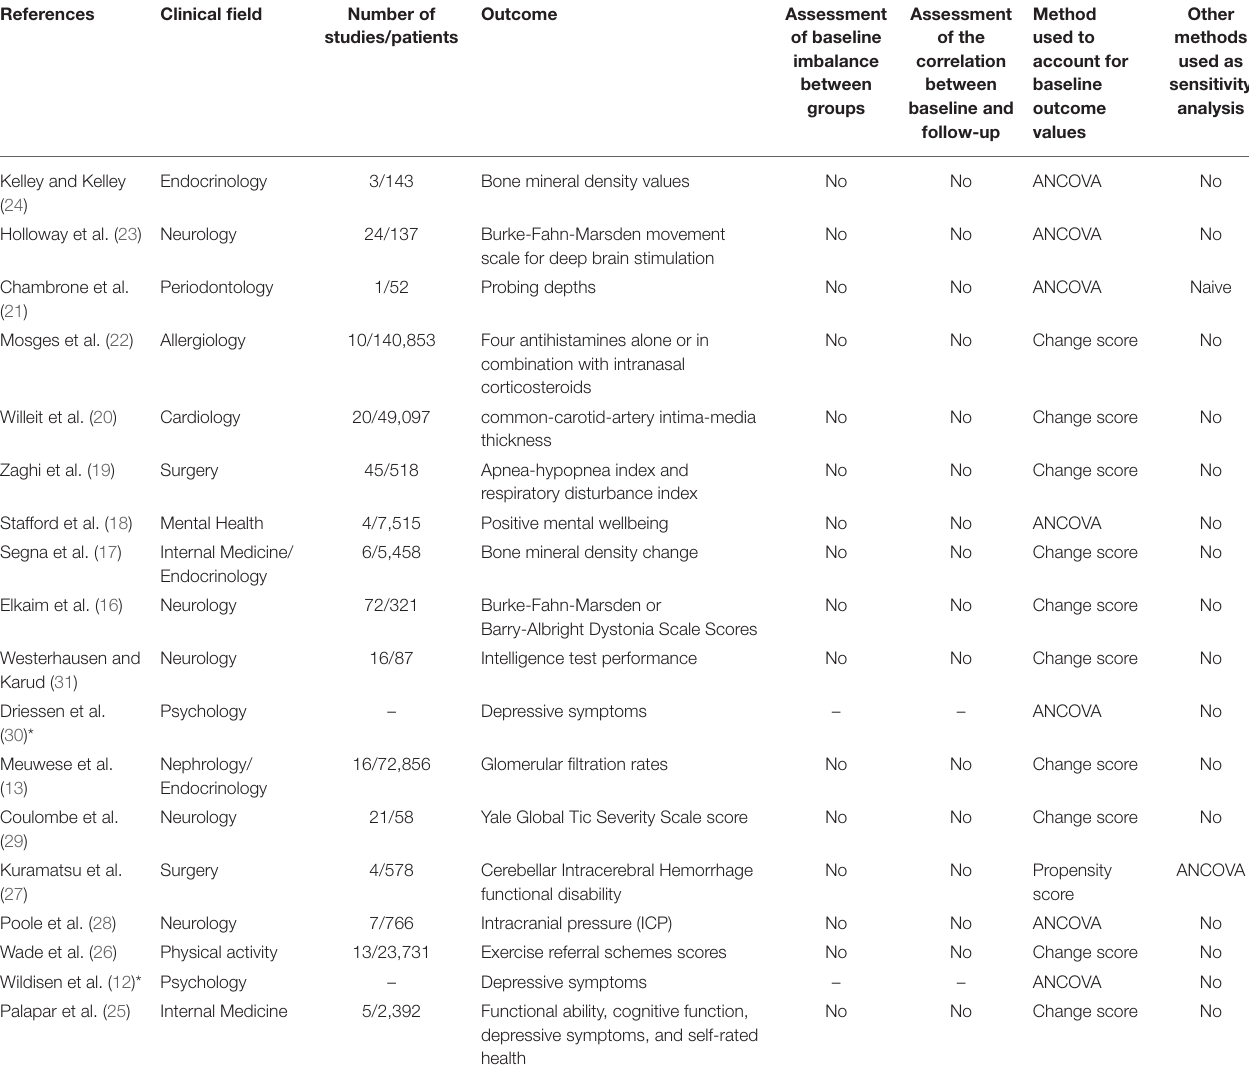
TABLE 1 | Characteristics of included individual participant data meta-analysis of non-randomized